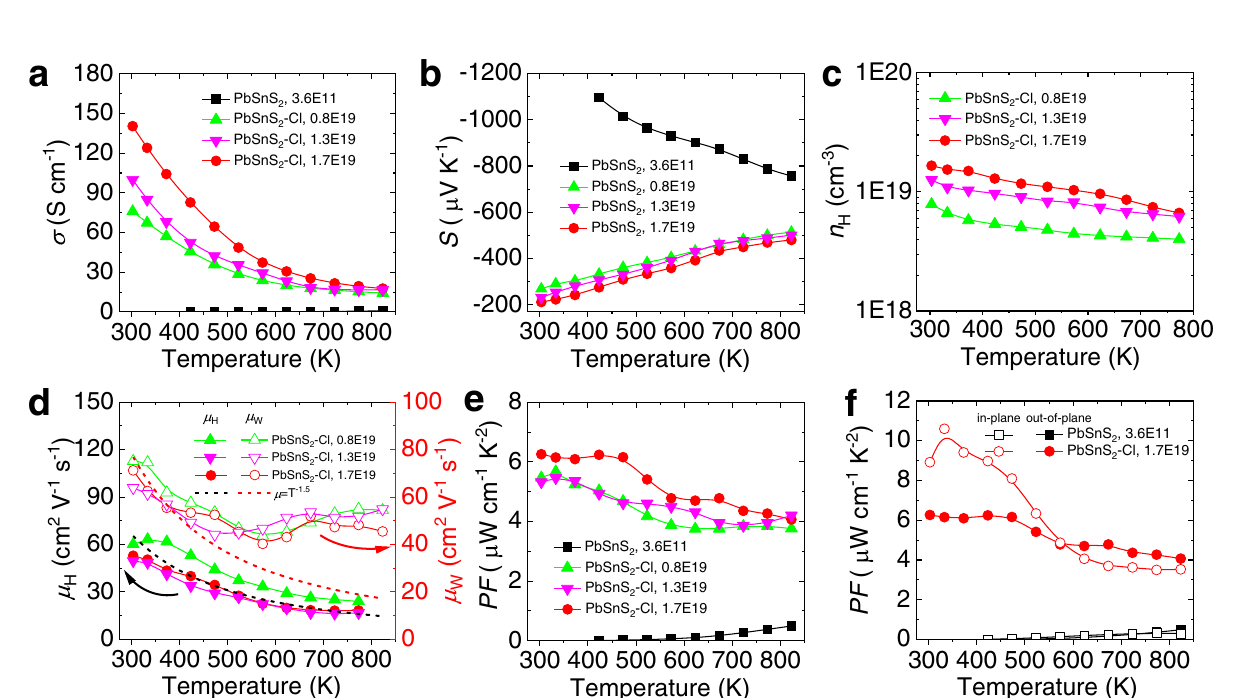
pattern. The HAADFimages along the zone axes of ( c ) [100], ( e ) [110] and( f ) [001]. d The ABF image along the zone axis [100]. Local magni fi cation and crystal struc- turemodelarepresentedattherightofthecorrespondingSTEMimage,wherethe black and gray mixed spheres represent Pb or Sn atoms, and the yellow spheres represent S atoms.